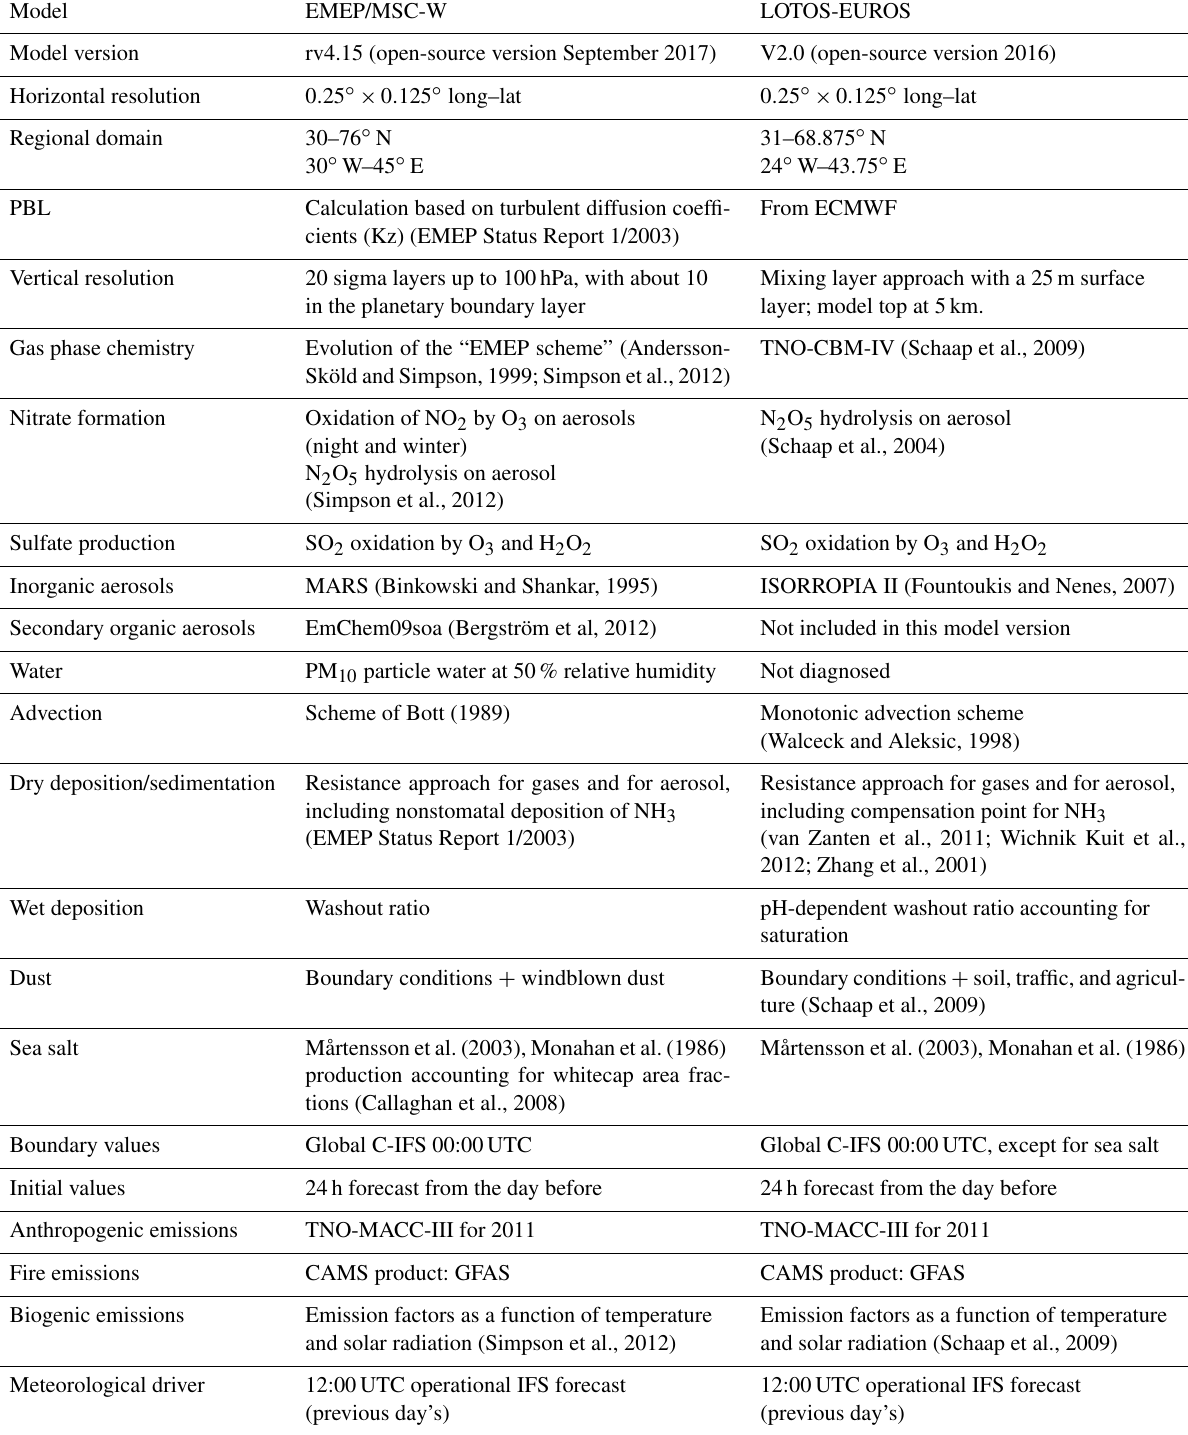
Table 1. Technical description of both models used in the SC calculation